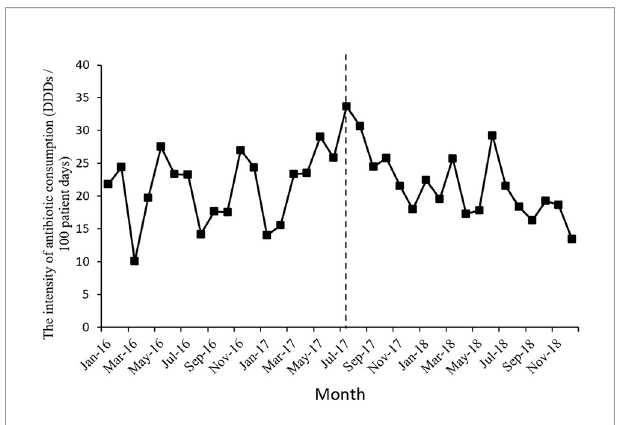
FIGURE 1 | The change of the intensity of antibiotic consumption per month pre- and post-intervention for the gastroenterology ward. The vertical line separated two segments (before and after the MPL